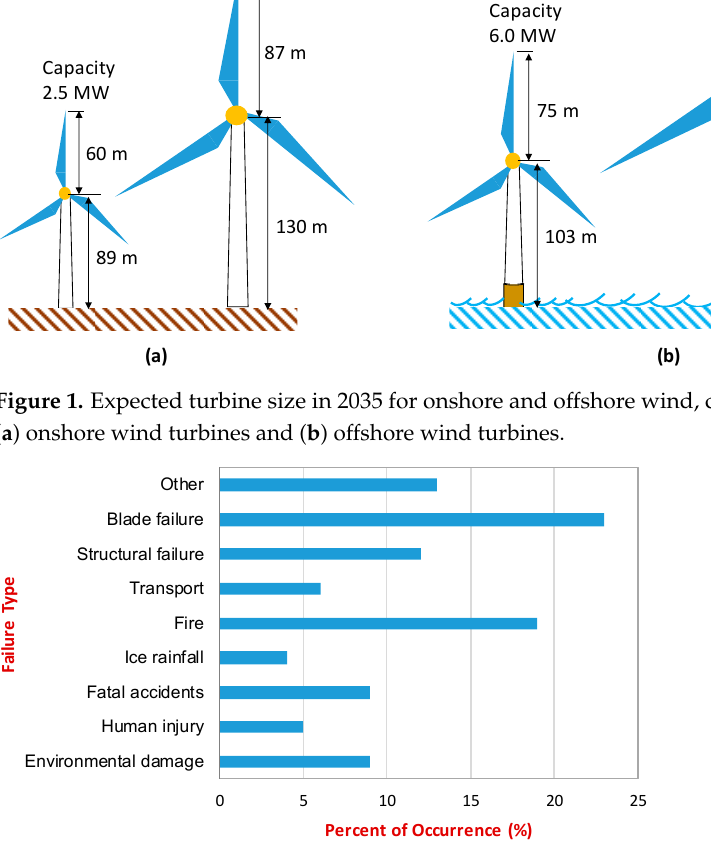
Figure 2. Failure types of wind turbine accidents.